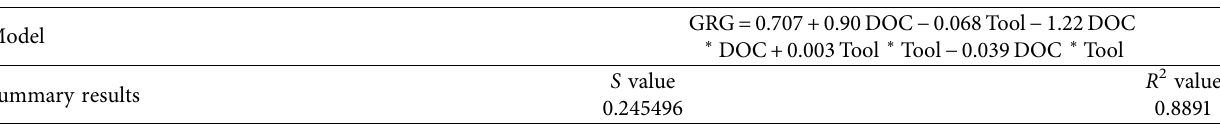
Table 22: Regression model and summary results for